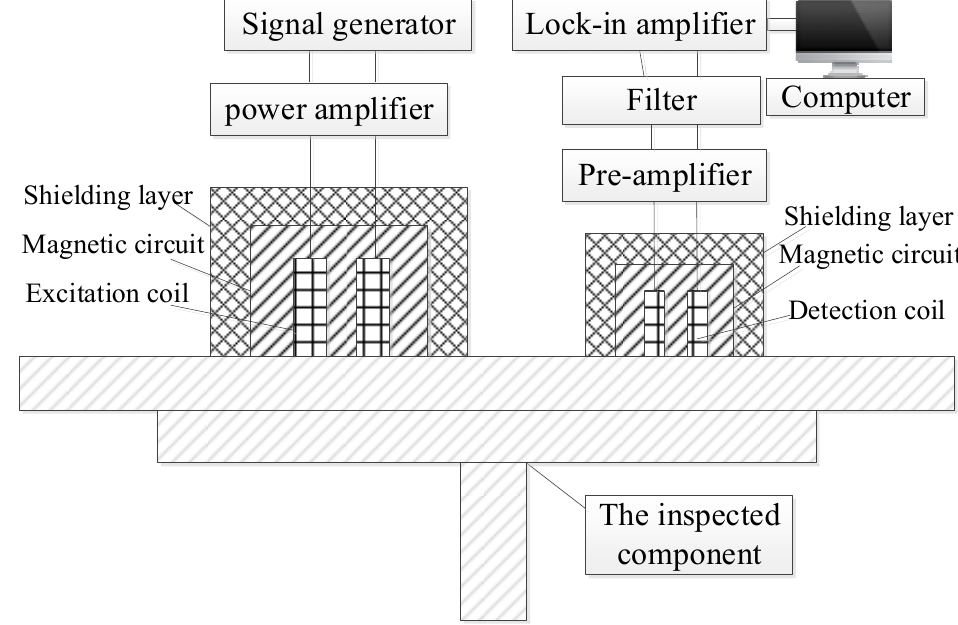
Figure 18. Block diagram of remote field eddy current testing system for aircraft long truss structure.